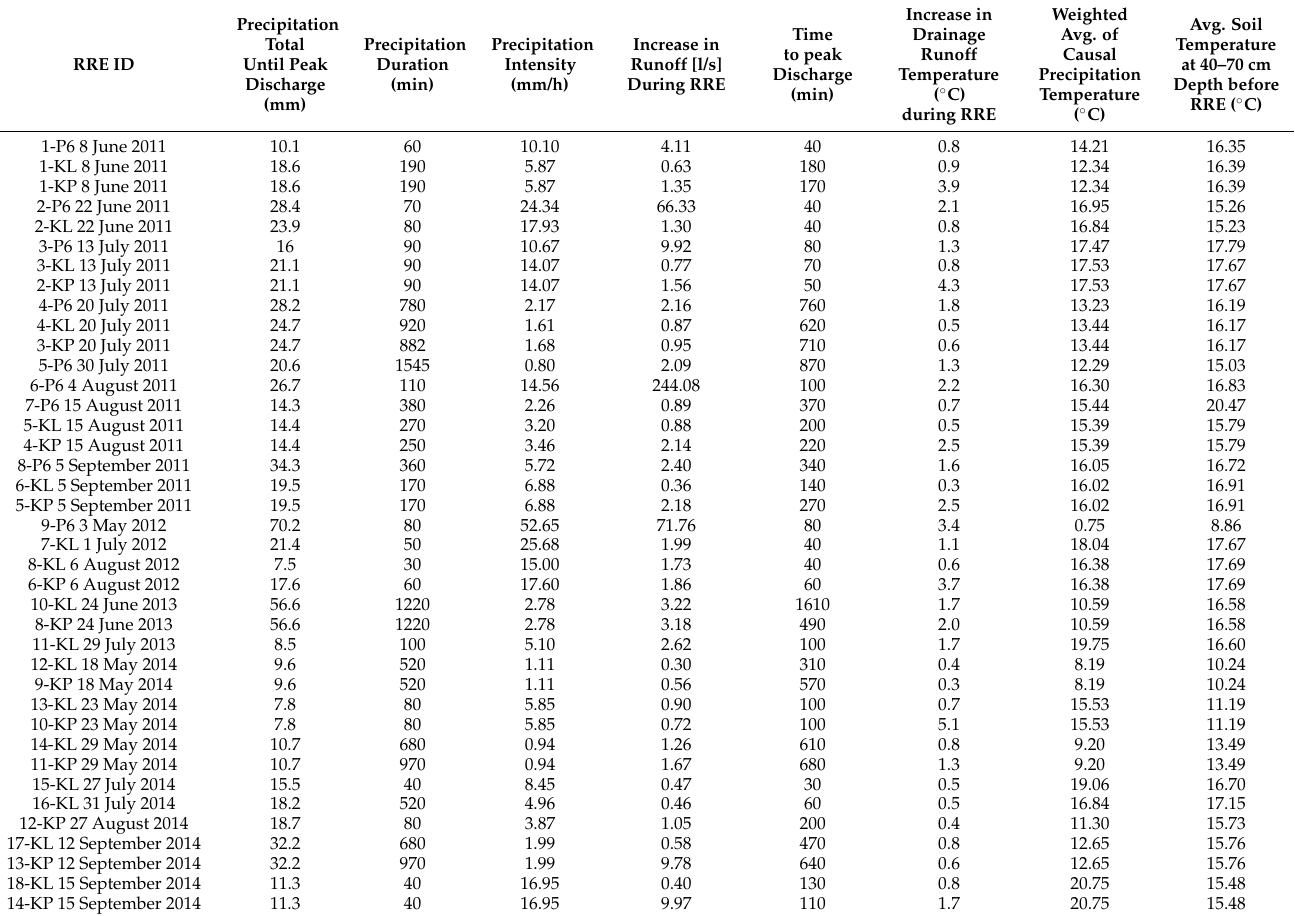
Table 2. Basic characteristics and parameters of evaluated RREs.